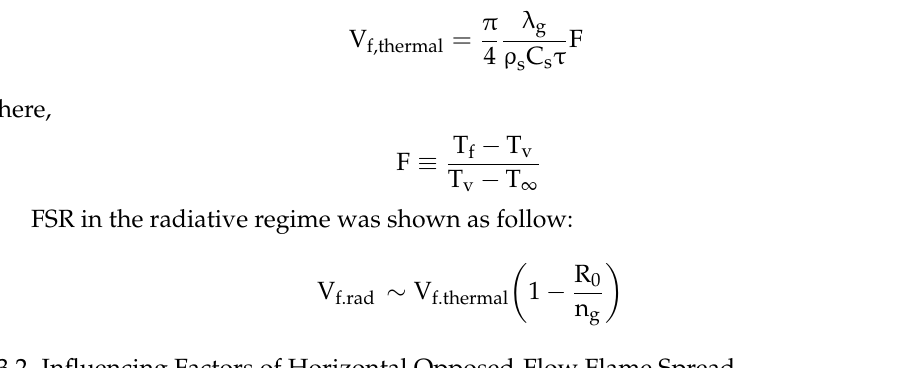
28 of 46 Figure 22. Relationship between y (cid:2899) (cid:3118) and V (cid:2917) [158]. The equation of the FSR over thermally thin samples could be shown as follow: V (cid:2916),(cid:2930)(cid:2918)(cid:2915)(cid:2928)(cid:2923)(cid:2911)(cid:2922) = π 4